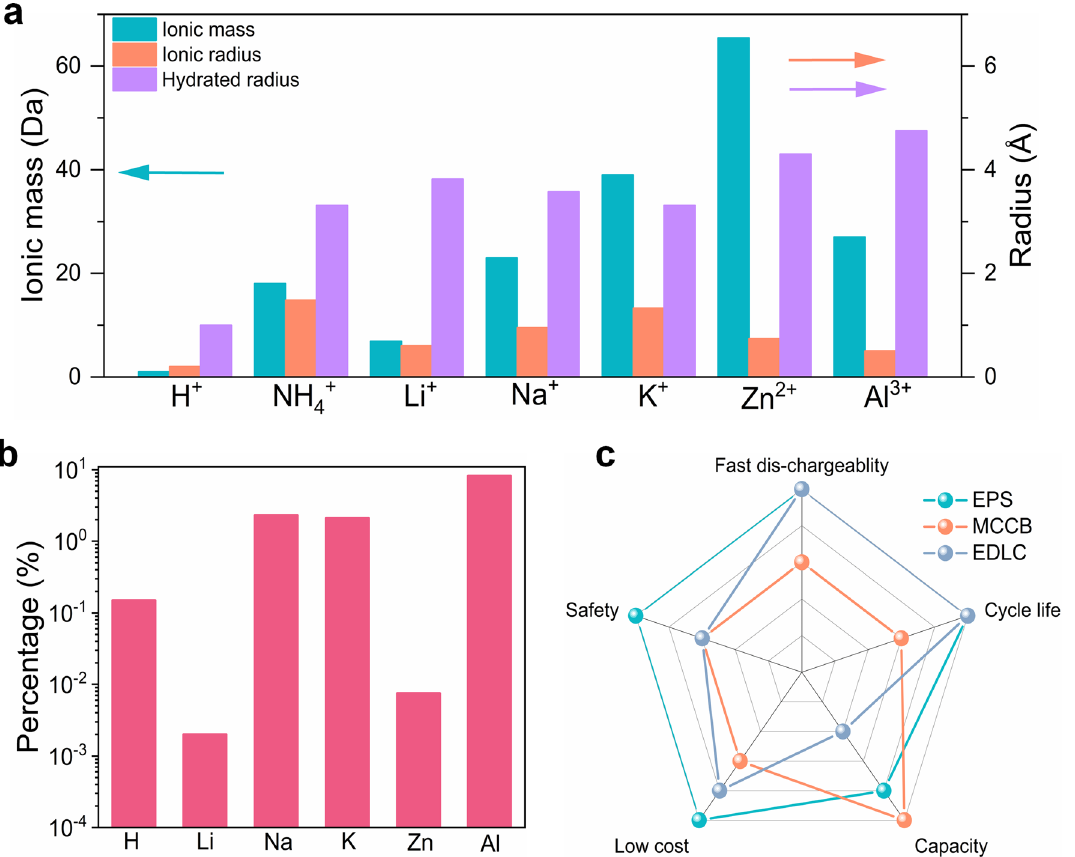
Fig. 1 a Ionic mass, ionic radius, and hydrated radius for typical cation charge carriers. b The abundance of various elements in the crust. c Radar plot comparing the property of different electrochemical energy storage systems, where EPS represents the electrochemical proton stor- age, MCCB represents metal ion charge carrier batteries, and EDLC represents electric double-layer